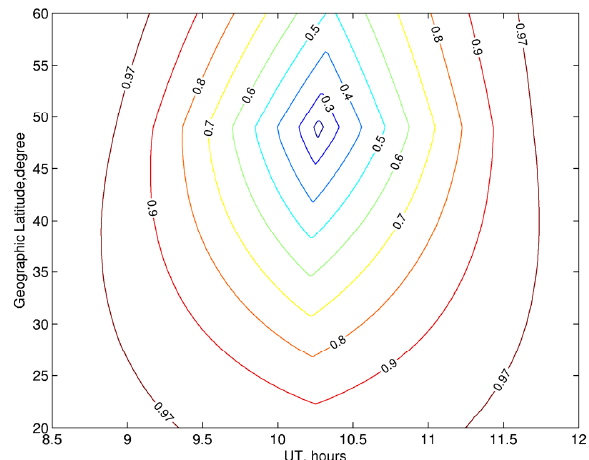
Figure 1. Contours of the revised eclipse factor, F R (UT, h, Φ , θ ), as a function of universal time 564 Fig. 1. Contours of the revised eclipse factor, F R (UT, h, 8 , θ) , (UT) and geographic latitude for an altitude of 200 km on the 1.67° E meridian during the solar 565 as a function of universal time (UT) and geographic latitude for an eclipse of August 11, 1999.566 altitude of 200km in the 1.67 ◦ E meridian during the solar eclipse of 11 August